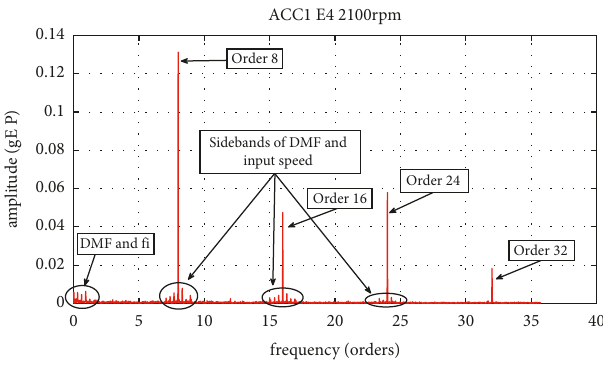
Figure 15: PCA components’